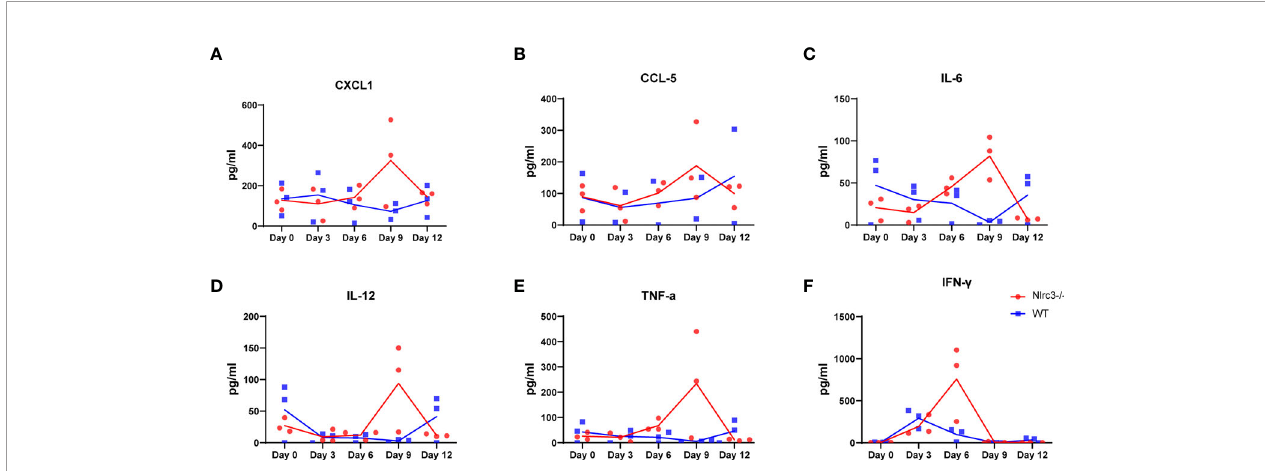
FIGURE 6 | In fl ammatory Response in HTNV-infected Mice. The serum of each mice was collected on 3, 6, 9, and 12 dpi for cytokine measurement. The levels of CXCL1 (A) , CCL5 (B) , IL-6 (C) , IL-12 (D) , TNF- a (E) IFN- g (F) in serum of HTNV-infected mice (pg/mL). Red dots and lines represent Nlrc3 − / − mice, and blue indicate WT mice. Bars are means ± SD. Nlrc3 − / − mice, n=3; WT mice,